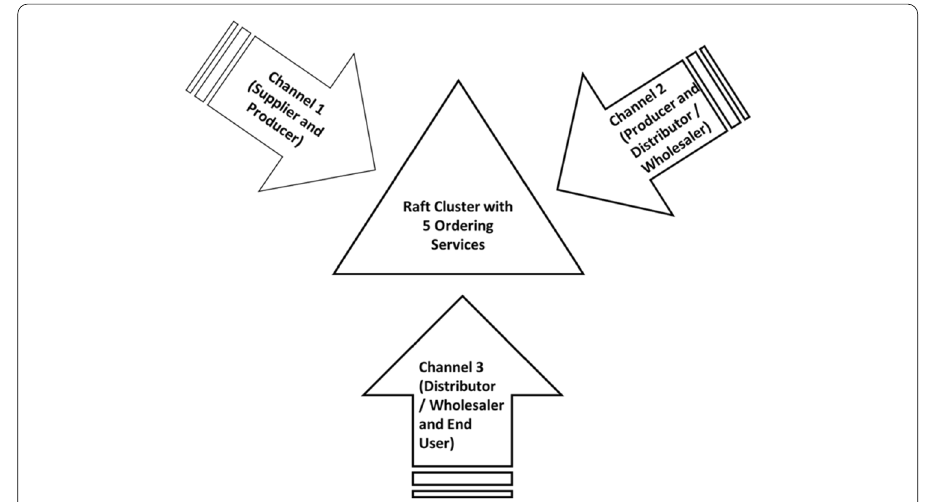
Fig. 2 Blockchain framework for Halal Supply Chain